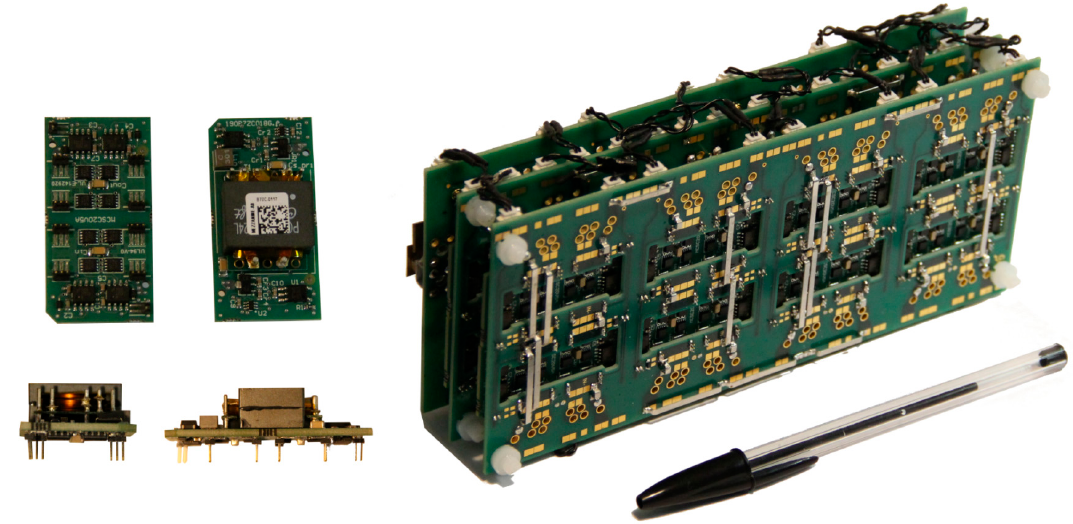
Figure 2. Picture of a single conversion standard cell (CSC) based on the DAB topology (left), picture of a power converter array (PCA), made with 16 CSCs, arranged in 4 columns, 2 lines and 2 boards (right). Table 1. Main characteristics of a single CSC and the PCA introduced as an illustration.